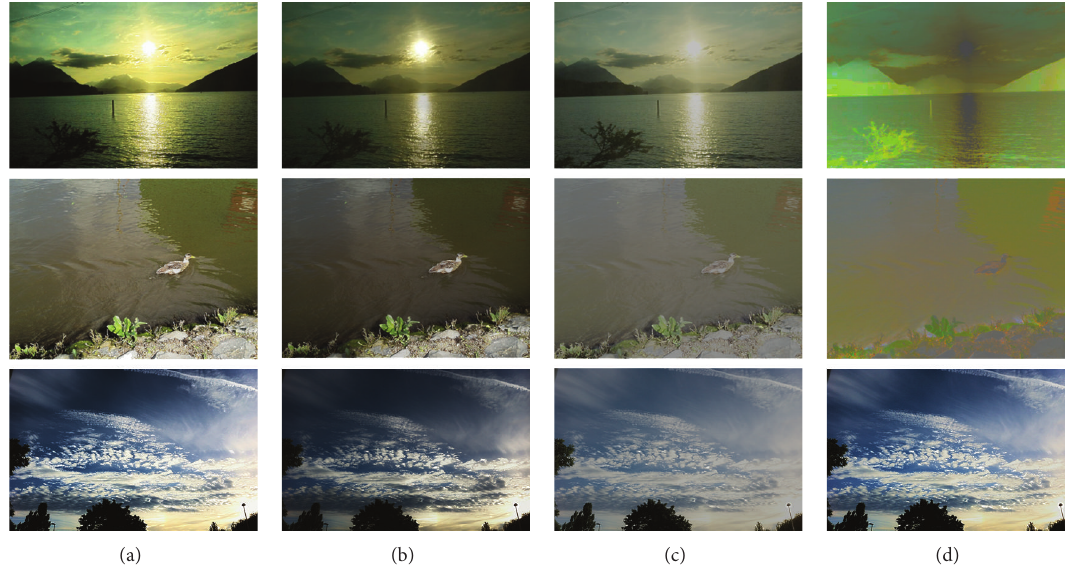
Figure 3: Tone mapped images of four algorithms, with Reinhard et al.’s operator [13]: (a) proposed, (b) iPG, (c) LDR2HDR, and (d) 𝛾 expansion.